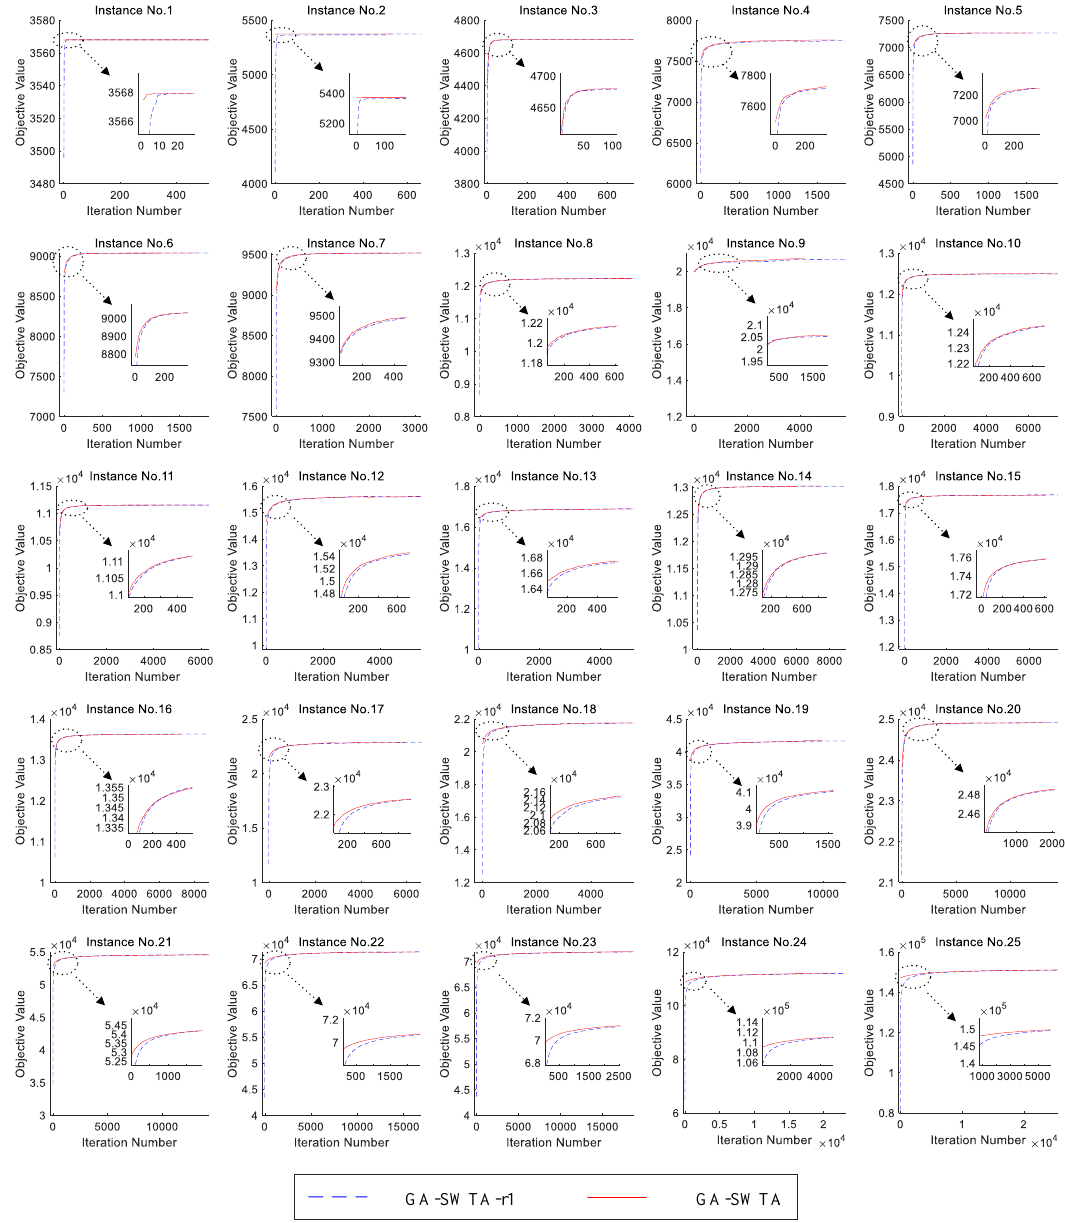
Figure 13. Comparison results of GA-SWTA and GA-SWTA-r1 with respect to the evolution of the mean value of the objective